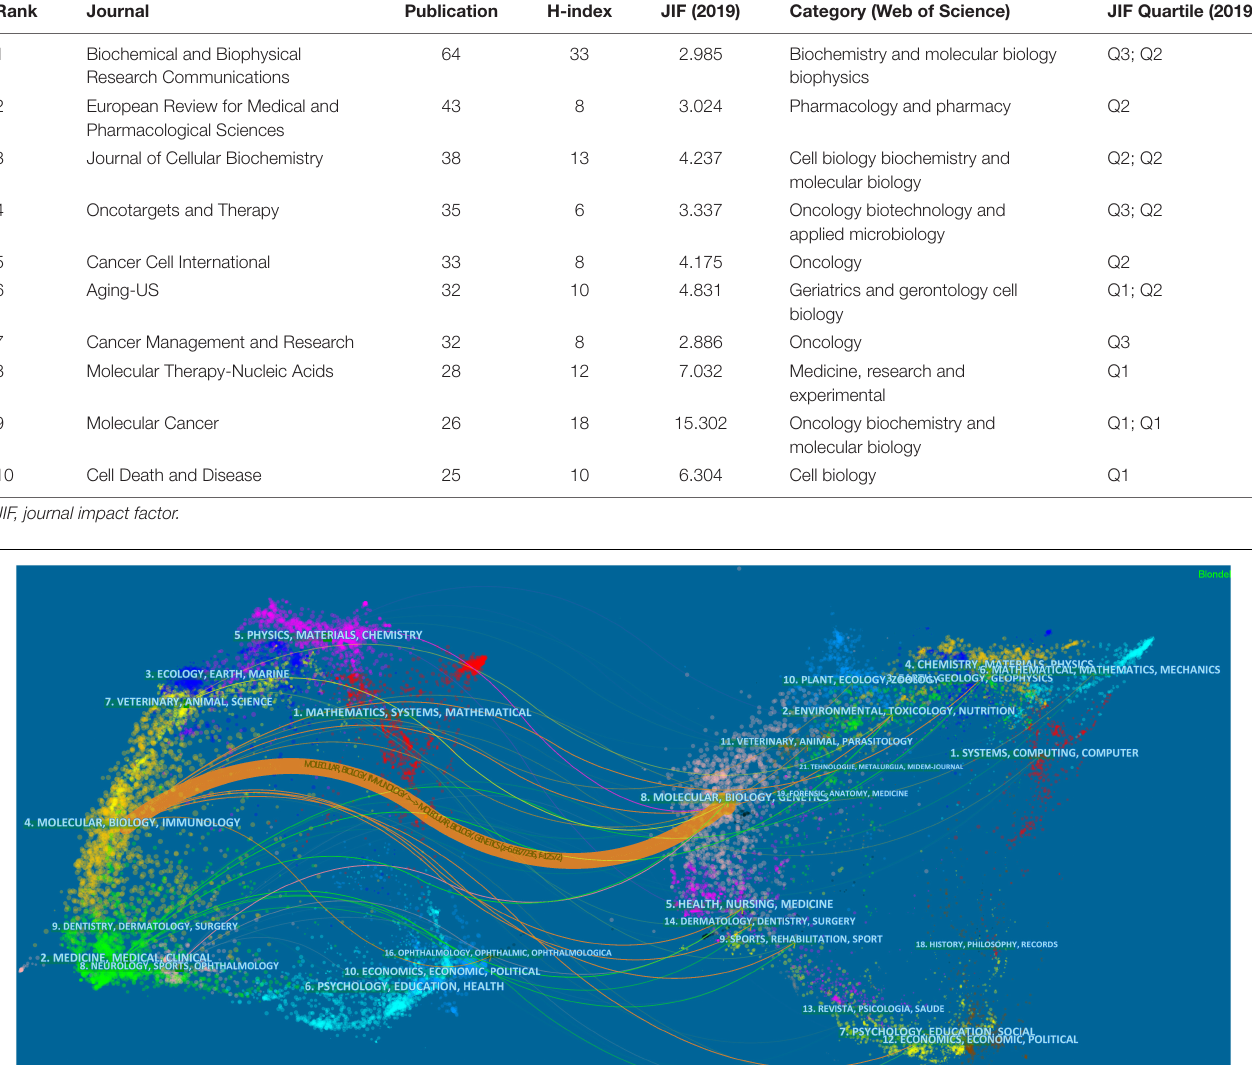
Frontiers in Cell and Developmental Biology |